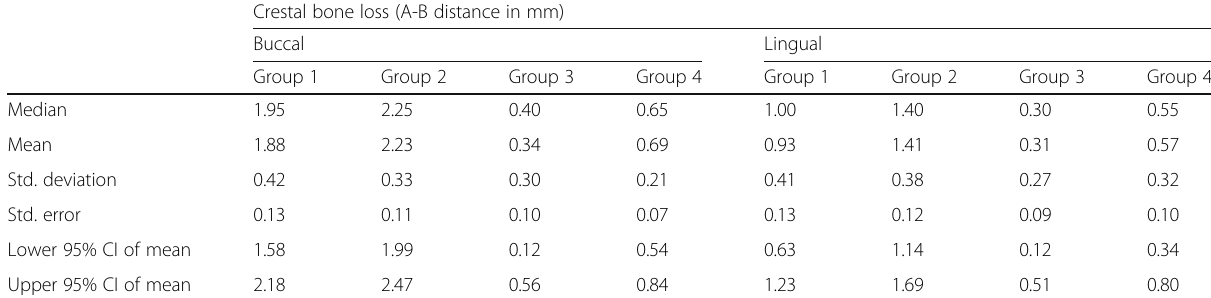
Table 1 Mean, median, standard deviation, and standard error for each group evaluated for lingual as well as buccal sites of the crestal bone height (in mm) for all groups